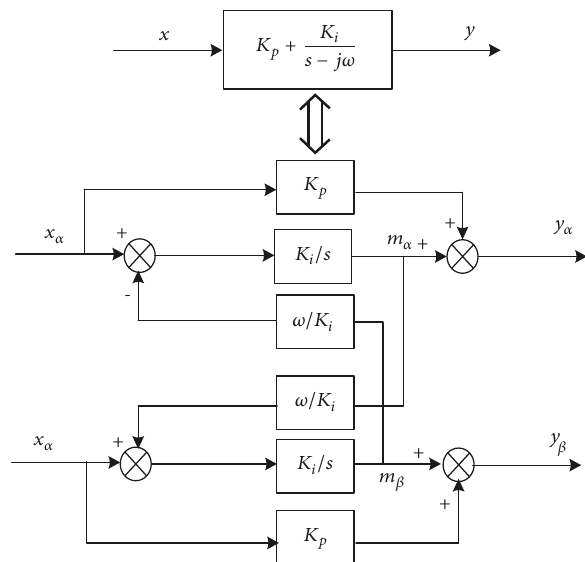
Figure 4: The structure diagram of PCI